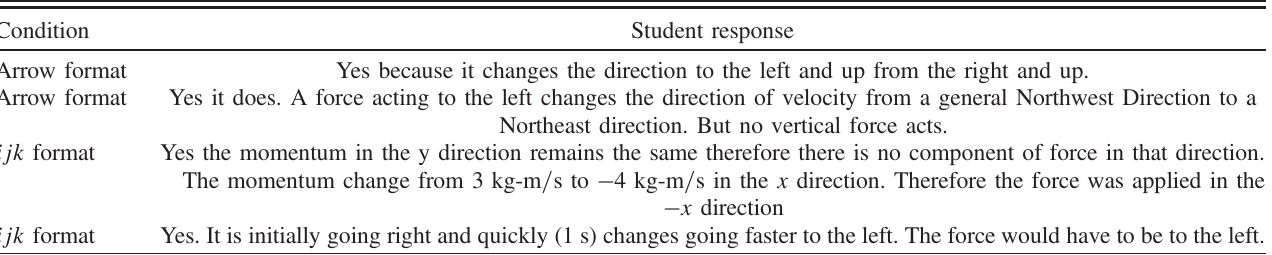
ADDING AND SUBTRACTING VECTORS: THE TABLE III. Examples of responses counted as at least partially correct to momentum-impulse question (Fig. 13) explaining why the numerical response obtained makes physical sense. Condition Student response Arrow format Yes because it changes the direction to the left and up from the right and up. Arrow format